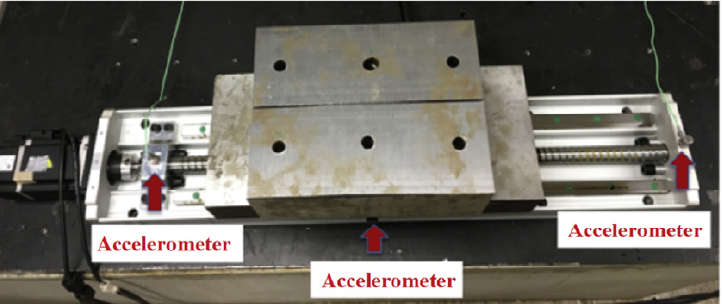
Figure 5. The ball screw test rig [63]. Reprinted with permission from Ref. [63]. Copyright 2020